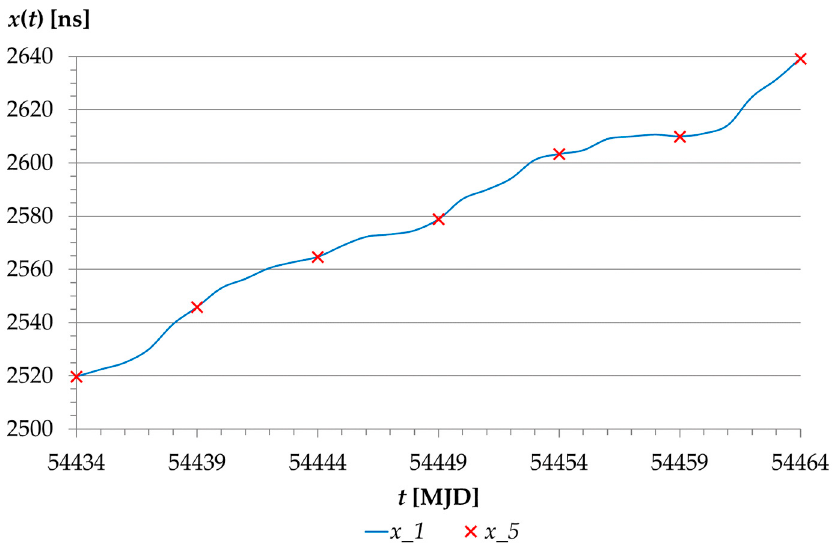
Figure 5. Exemplary values of x ( t ) calculated from (1) for xb ( t ) determined with the 1-day ( x _1) and 5-day ( x _5) interval for a period of one month for UTC(PL).